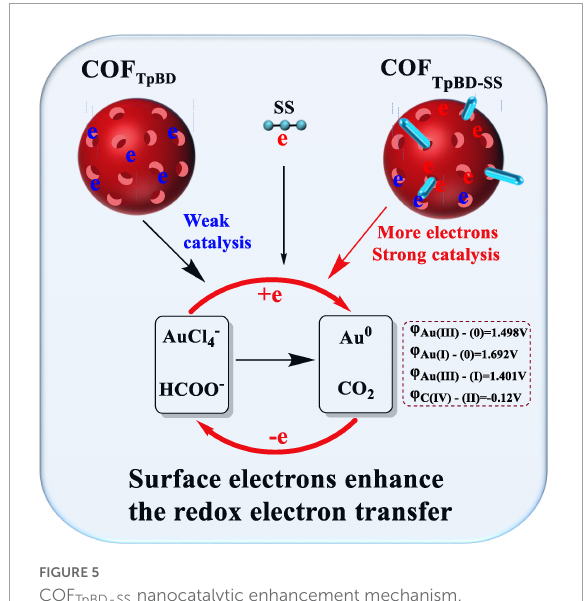
FIGURE5 COF TpBD - SS nanocatalytic enhancement